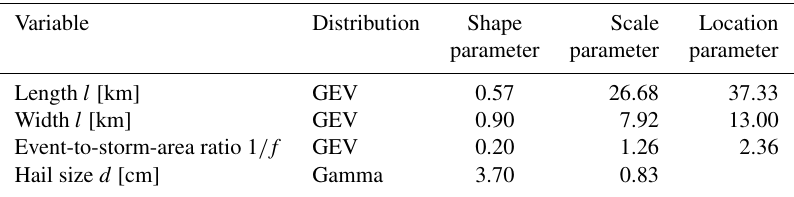
Table 1. Potential hail event property distributions and parameters (computed with the standard MATLAB mle